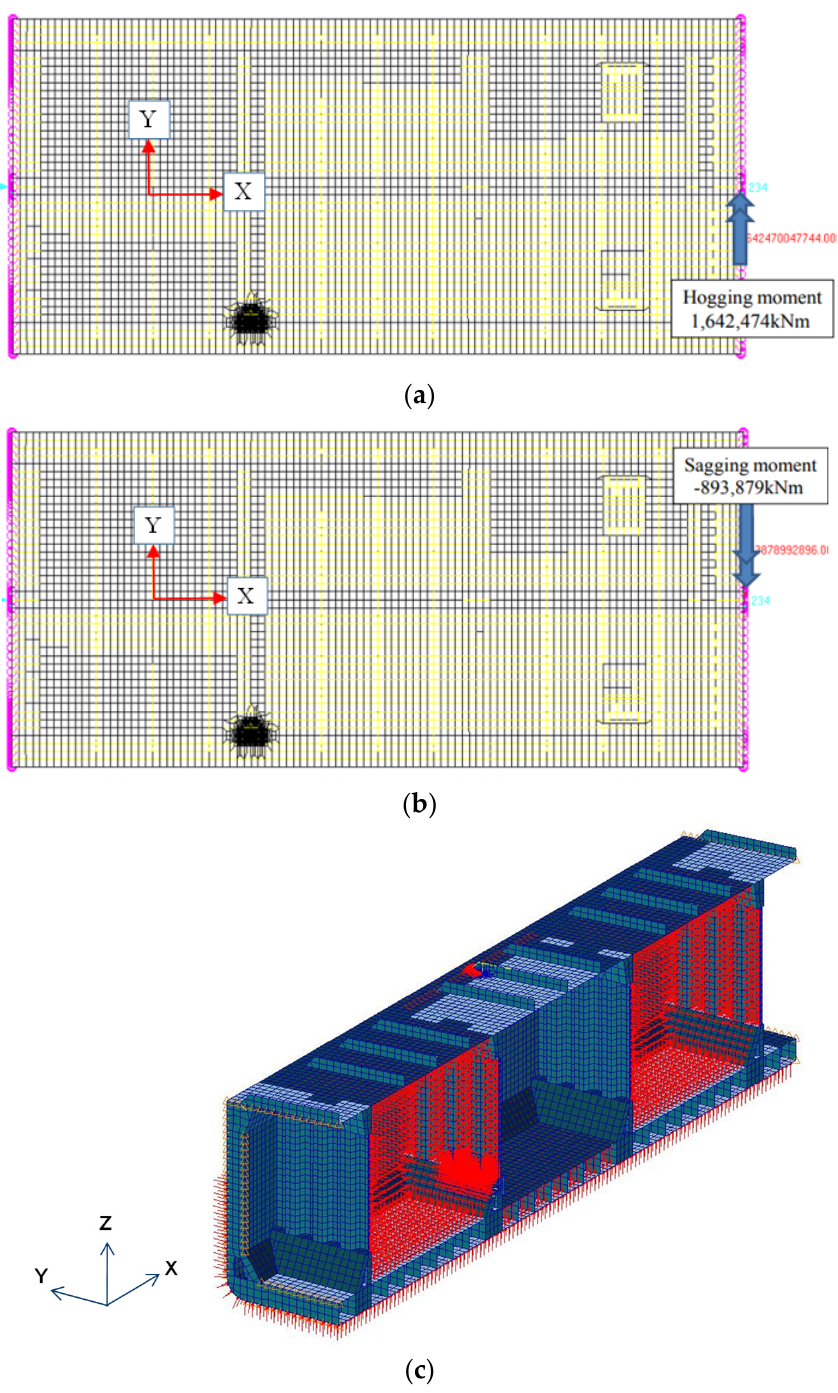
Figure 7. Load condition (plan view): ( a ) hogging application; ( b ) sagging application; and ( c ) inter- nal/external pressure application.